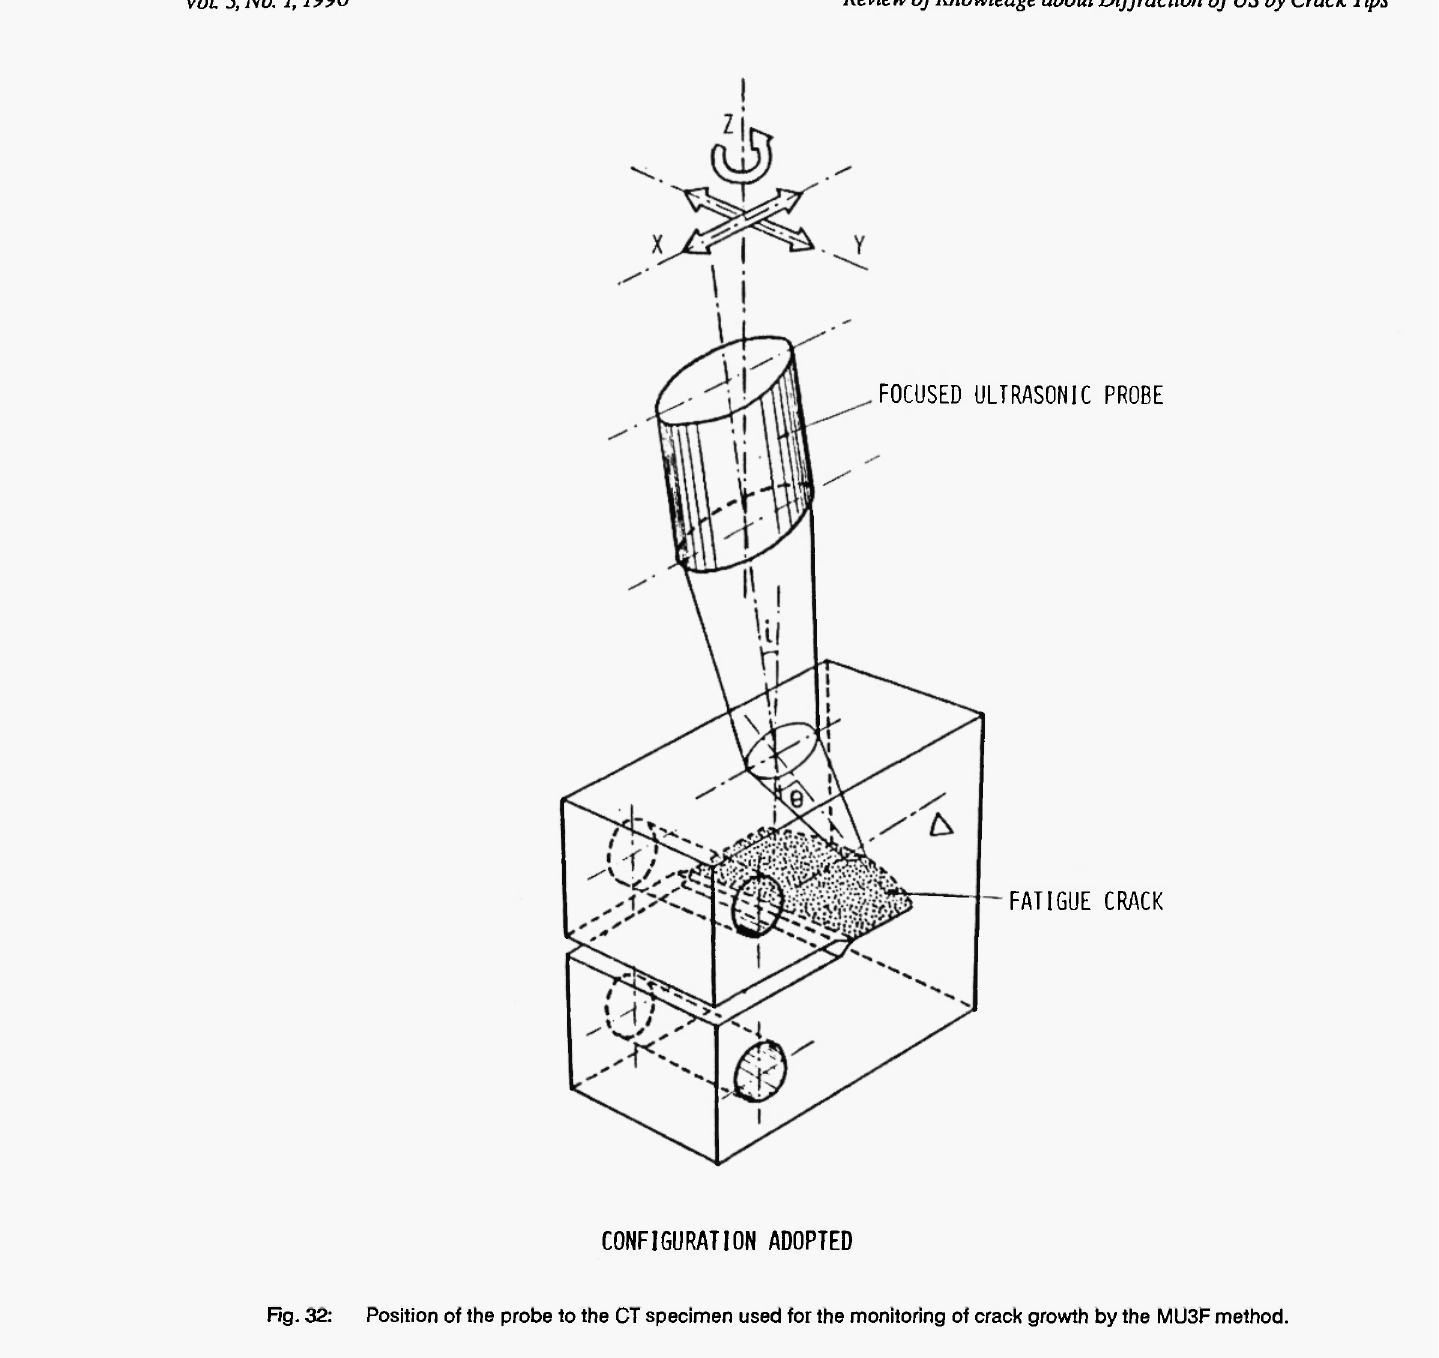
Position of the probe to the CT specimen used for the monitoring of crack growth by the MU3F